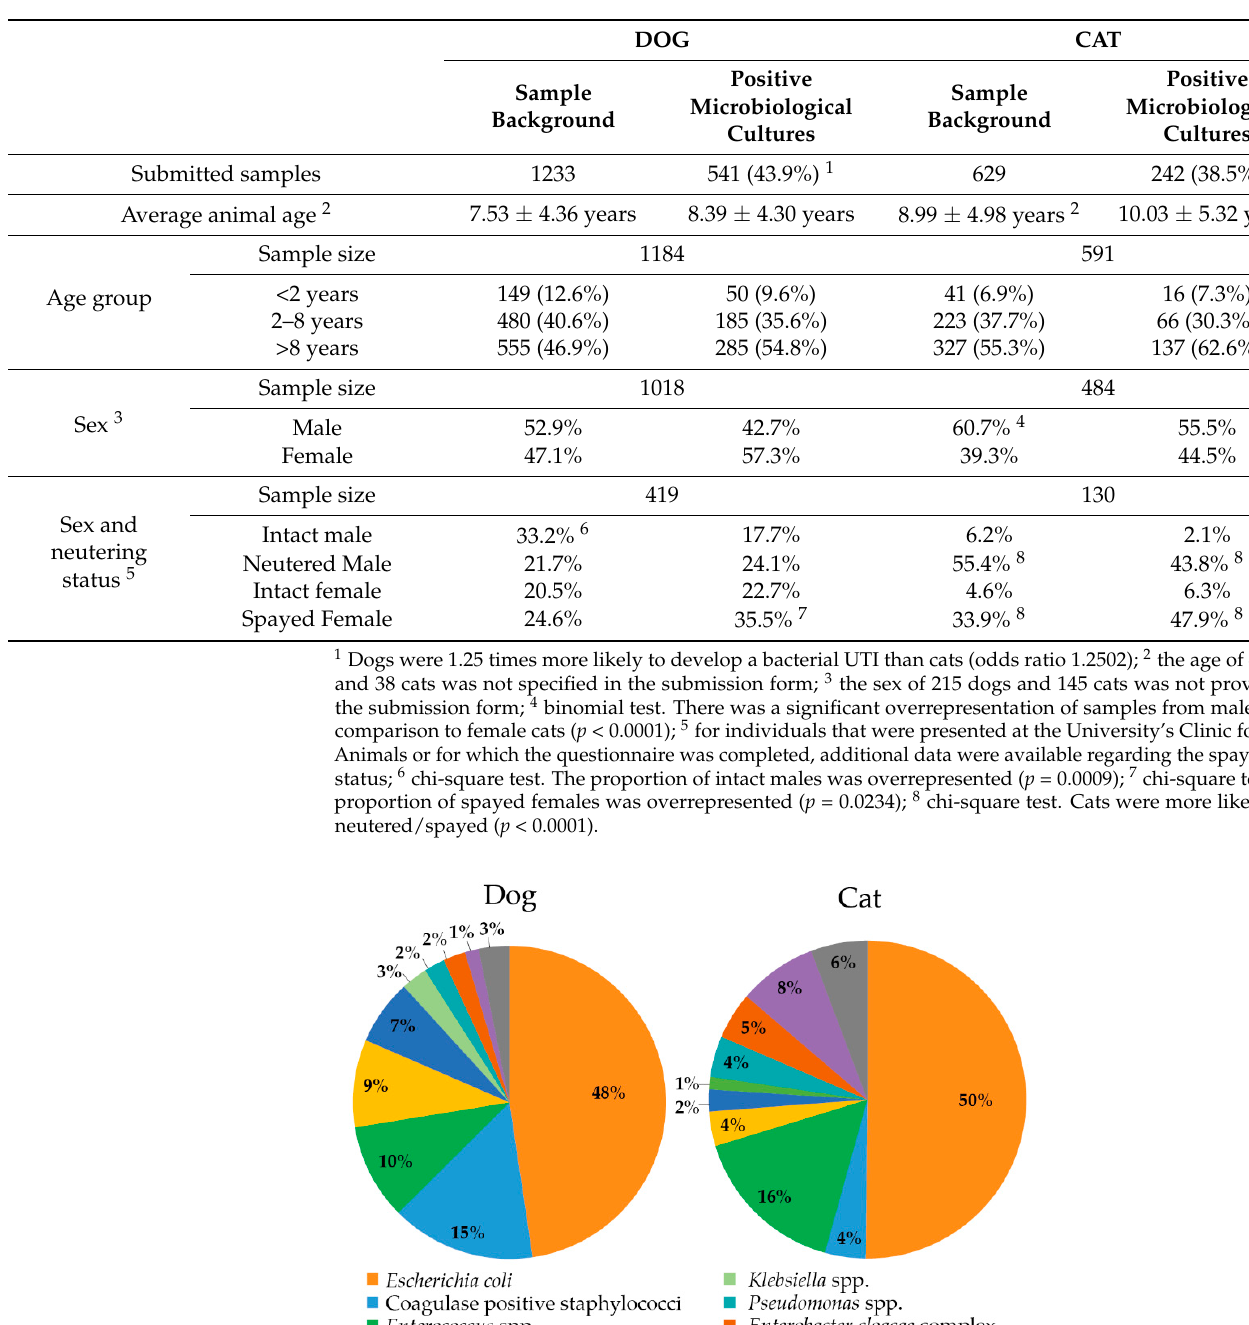
Table 1. Number of positive microbiological cultures, age, and sex of animals (1013 dogs and 536 cats).